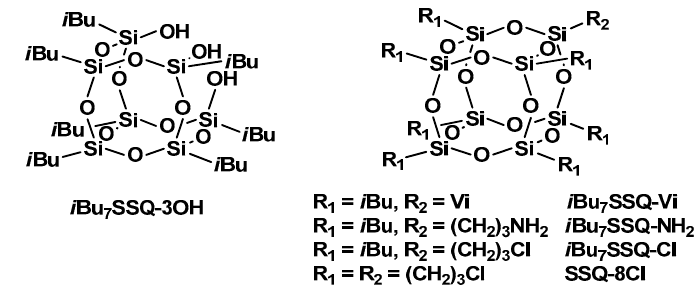
Figure 1. The Silsesquioxane (SSQ) compounds used in this work.